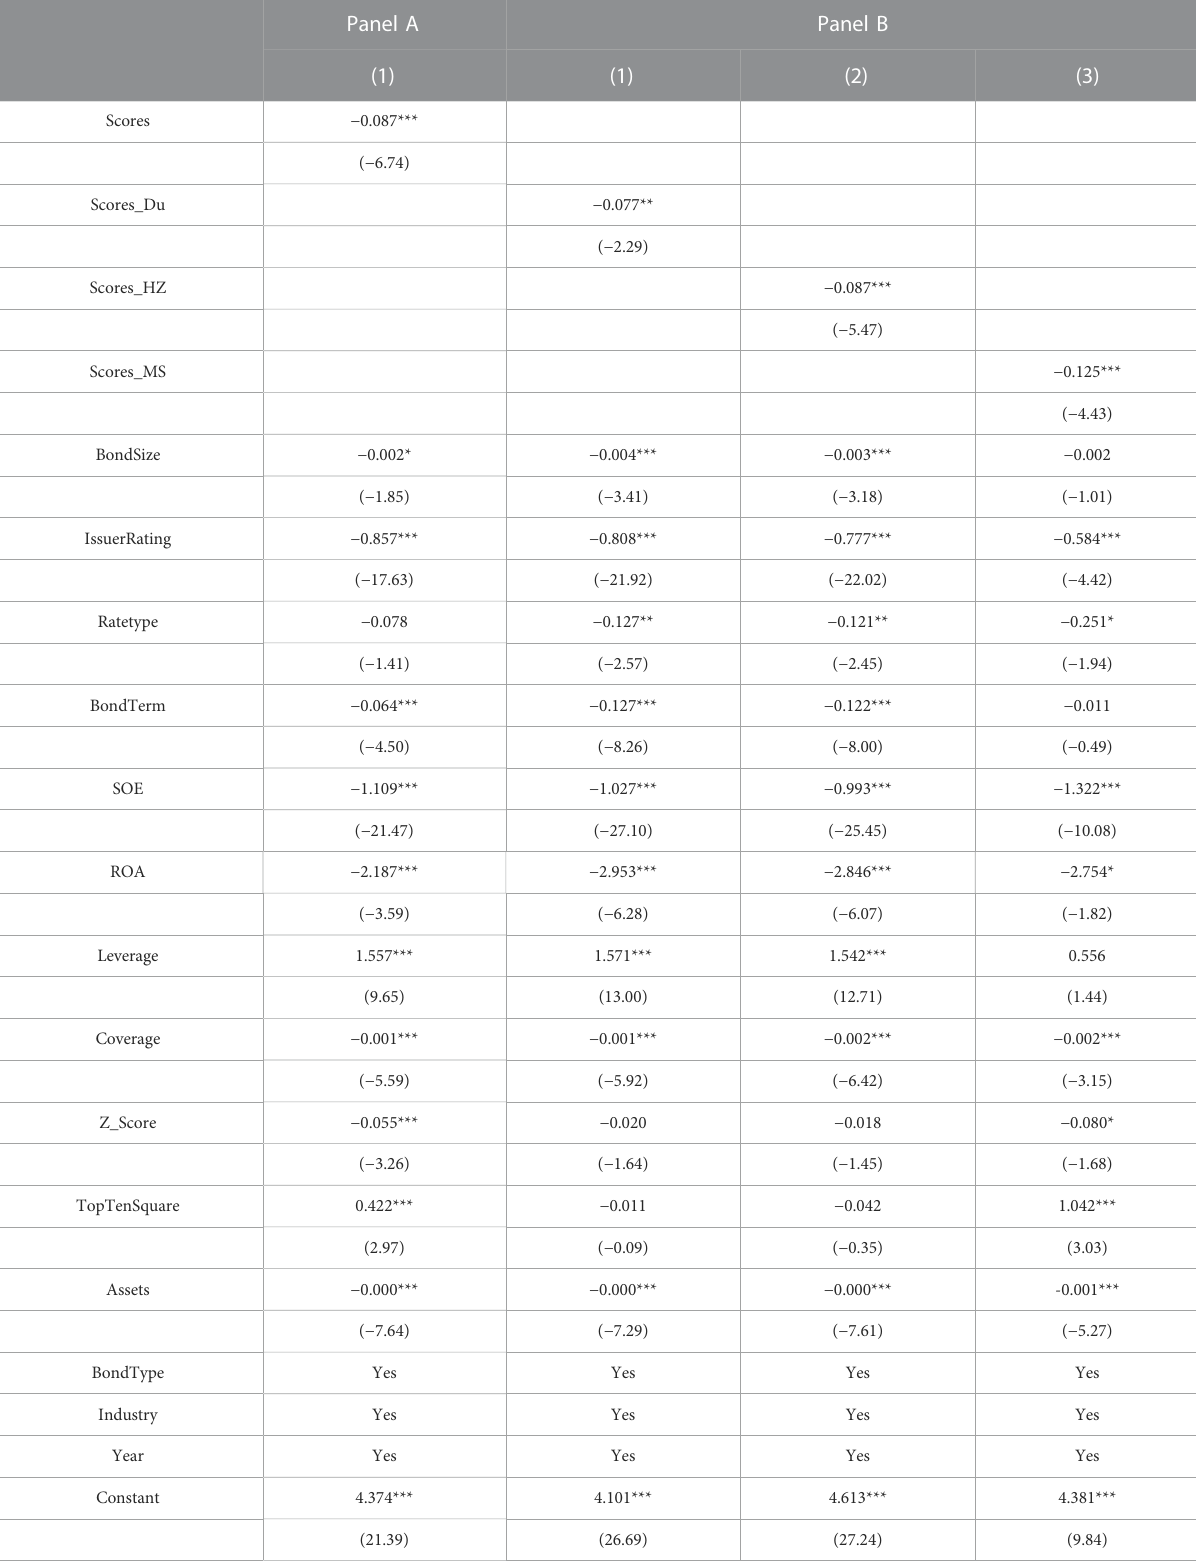
TABLE 4 Baseline regression and robustness